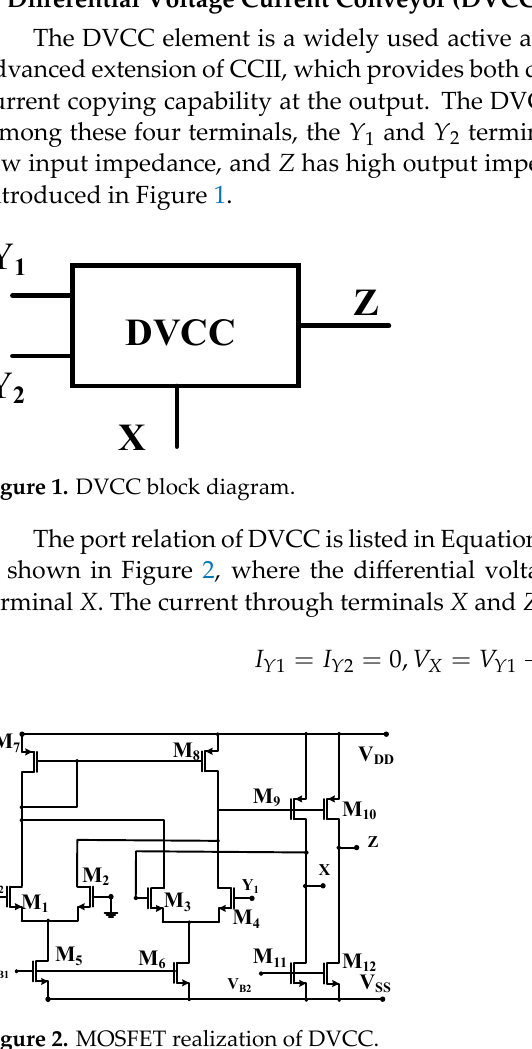
Figure 2. MOSFET realization of DVCC.